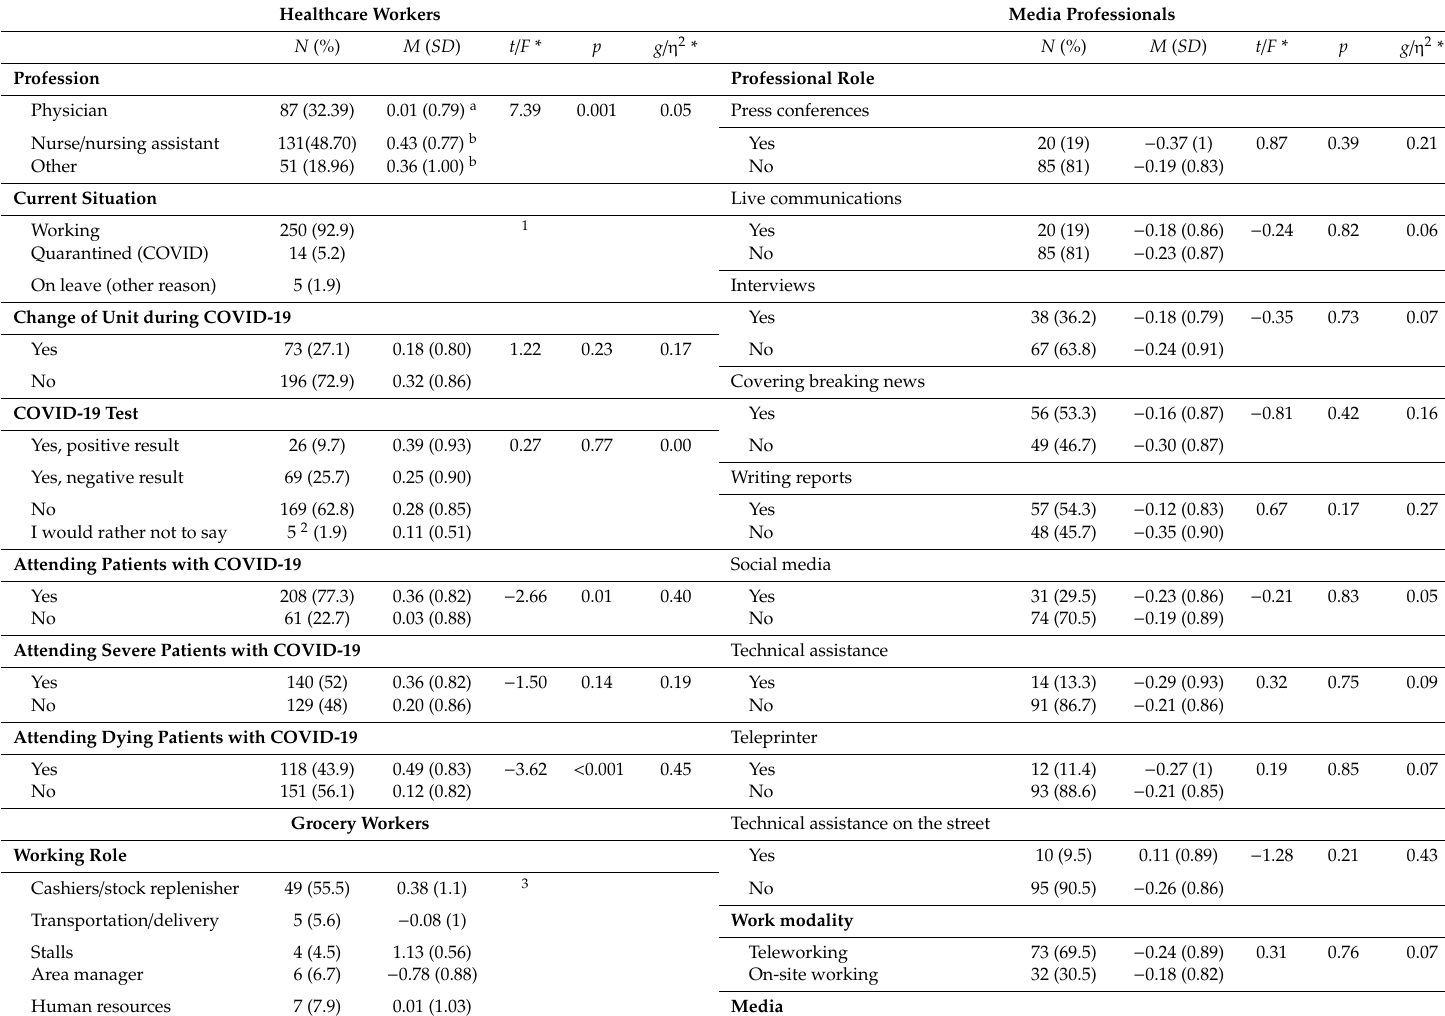
Table 5. Descriptive data of specific work-related variables and their association with psychological impact (IES-R standardized factorial score). Healthcare